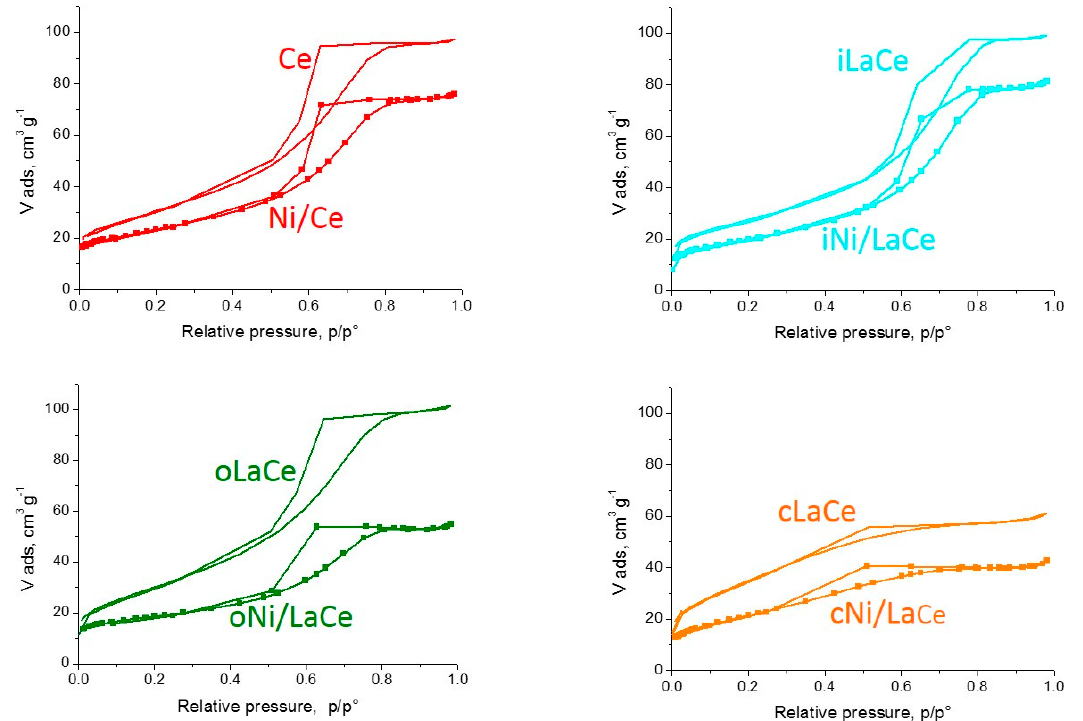
Figure 1. N 2 physisorption isotherms of the supports and the corresponding catalysts.